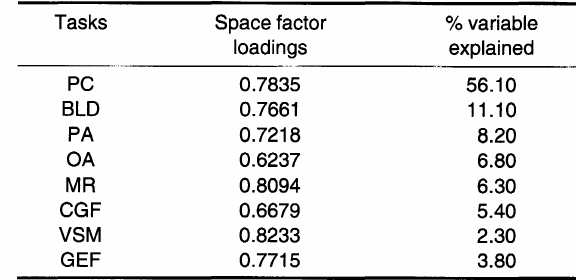
TABLE III. Factor structure abstracted from performance on eight tasks by the PO patients and NCs (n = 54) Tasks Space